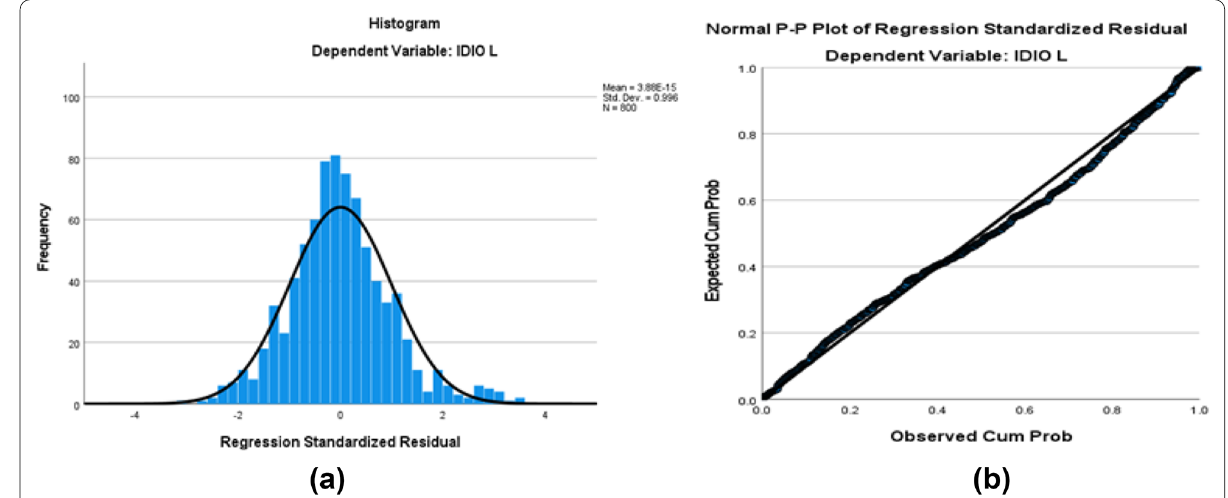
Fig. 1 a Histogram and b P–P plot for idiosyncratic